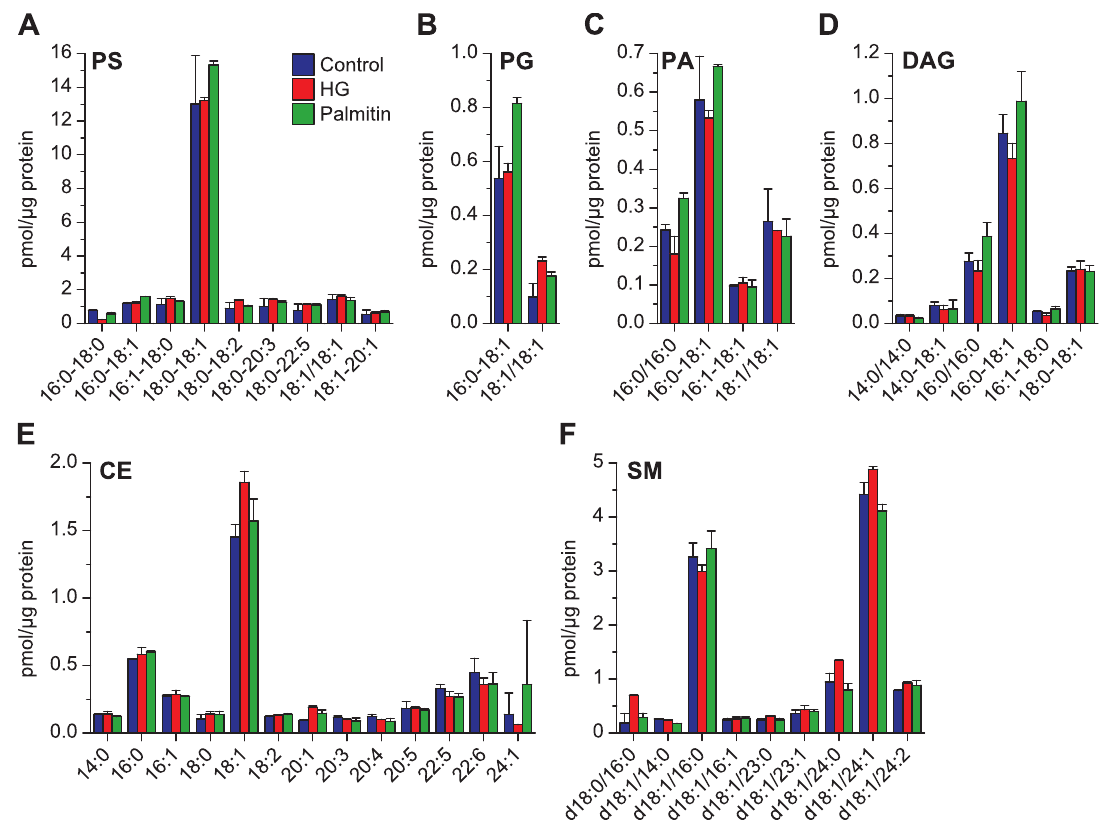
Figure 6. Quantitative lipid analysis of PS, PG, PA, DAG, CE and SM. The major species of ( A ) PS, ( B ) PG, ( C ) PA, ( D ) DAG, ( E ) CE, and ( F ) SM in HEp-2 cells treated with HG (20 m M), palmitin (20 m M) or ethanol (0.1%, as control) for 24 hours. The SM species labeled d18:1/23:0 and d18:1/23:1 may alternatively be d18:1//22:0(OH) and d18:1/22:1(OH). The species shown here are species comprising more than 2% of the total mass of the lipid class for at least one of the